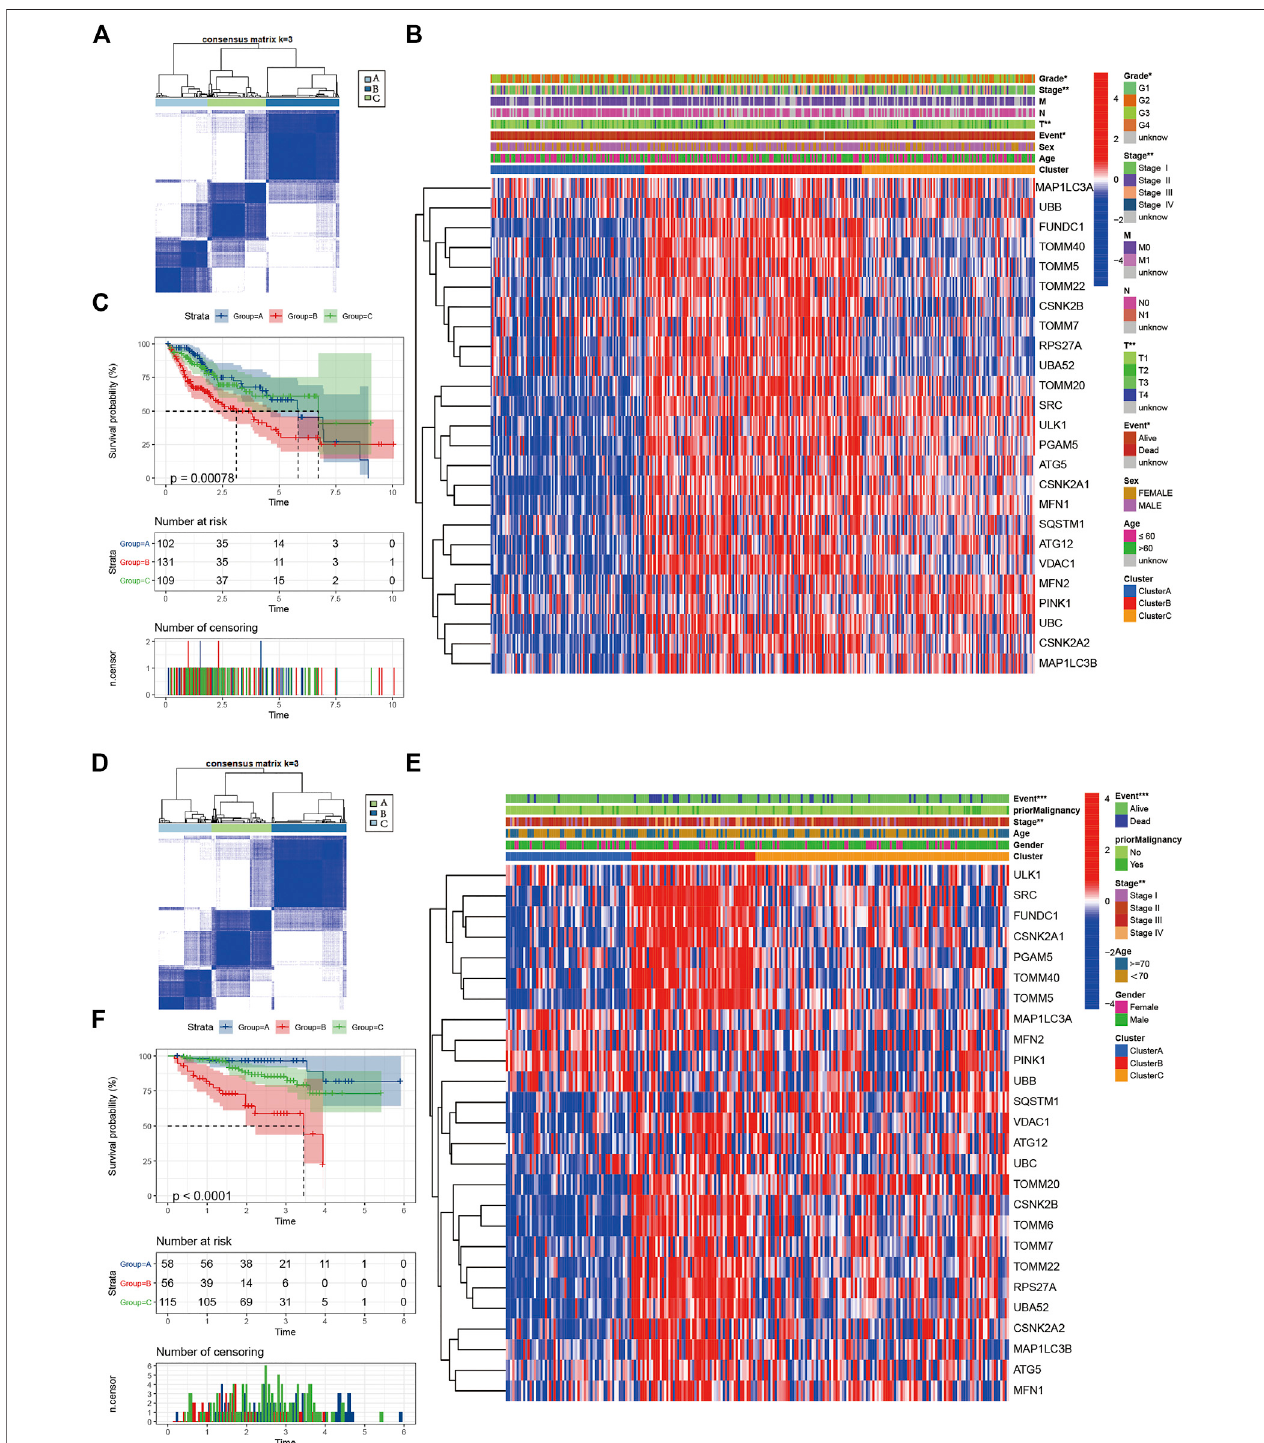
FIGURE 2 | Identify different mitophagy subtypes (A) Consensus matrices of the TCGA cohort for k (cid:1) 3 (B) Unsupervised clustering of overlapping mitophagy regulatorsinTCGAcohortstoclassifypatientsintodifferentsubtypes(clusterA-C).Grade,stage,gender,survivalstatusandagewereutilizedaspatientannotations (C) SurvivalanalysesforthethreeclustersinTCGAcohortincluding102casesinclusterA,131casesinclusterB,and109casesinclusterC.Kaplan-MeiercurveswithLog- rank p value < 0.001 showed a signi fi cant survival difference among three clusters. The cluster B showed signi fi cantly worse OS than the other two clusters (D) Consensus matrices of the ICGC cohort for k (cid:1) 3 (E) Unsupervised clustering of overlapping mitophagy regulators in ICGC cohorts to classify patients into different subtypes(cluster A-C).Stage,gender,survivalstatus andagewereutilizedaspatient annotations (F) Survivalanalyses forthethree clustersinICGC cohortincluding58 cases in cluster A, 56 cases in cluster B, and 115 cases in cluster C. Kaplan-Meier curves with Log-rank p value < 0.001 showed a signi fi cant survival difference among three clusters. The cluster B showed signi fi cantly worse OS than the other two clusters.